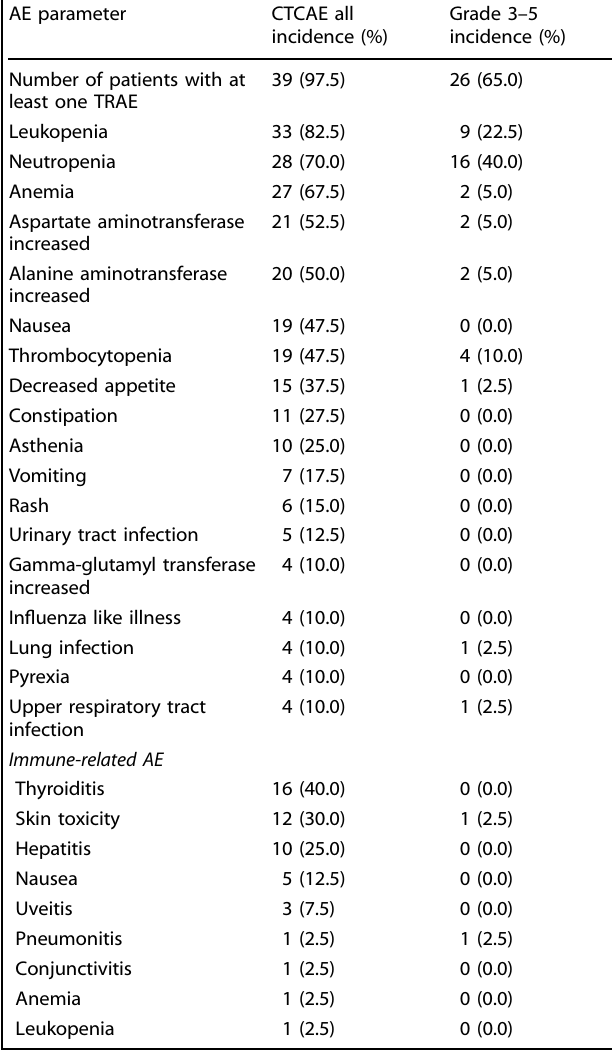
Table 2. Treatment-related and immune-related adverse events in this